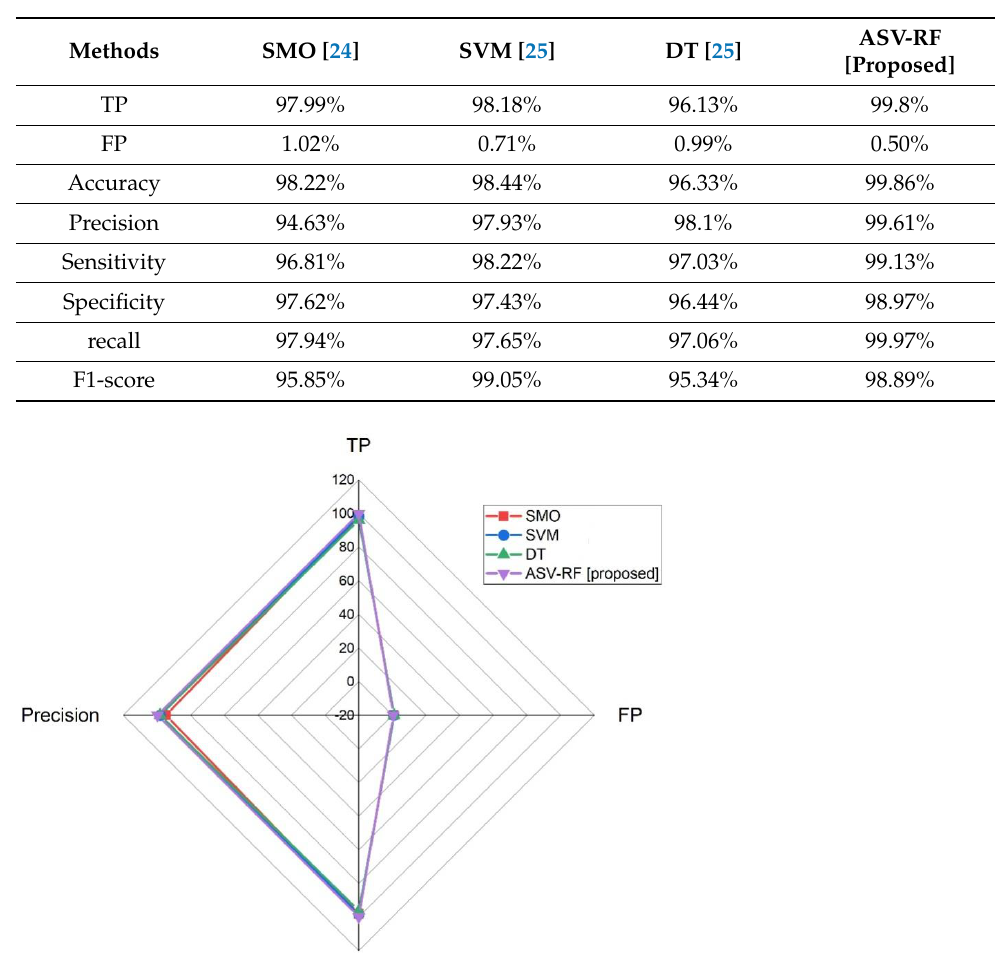
Table 3. Comparative assessment of proposed and existing methods.